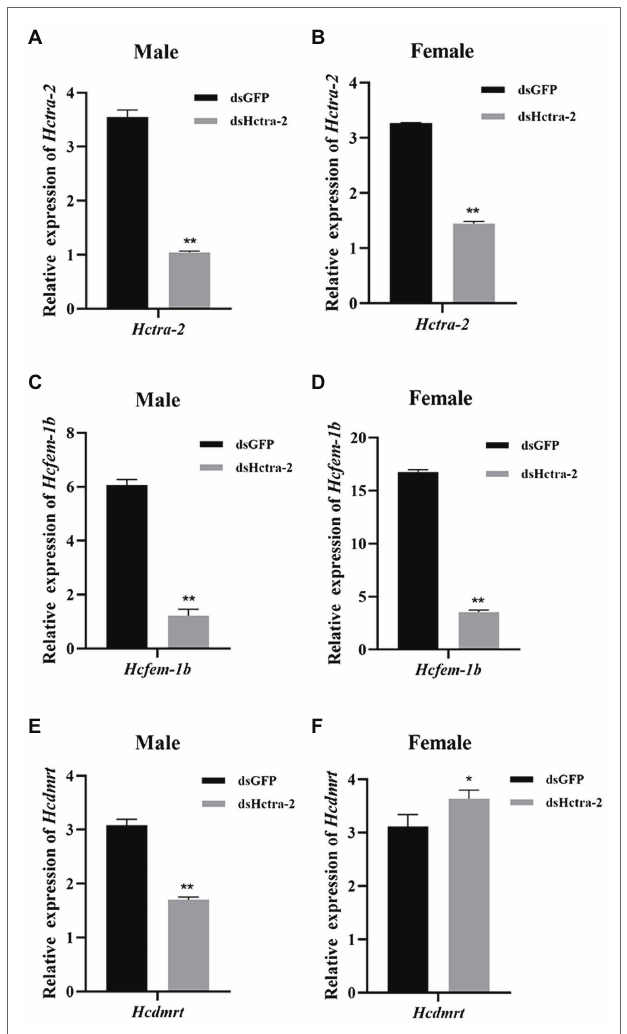
FIGURE 7 | Effects of dsHctra-2 injection on the expression of Hctra-2 , Hcfem-1b , and Hcdmrt genes in testes and ovaries of H. cumingii . dsGFP, treated with dsGFP and used as RNAi control group; dsHctra-2, treated with dsRNA of Hctra-2 as RNAi experiment group. (A) The expression of Hctra-2 gene in testes. (B) The expression of Hctra-2 gene in ovaries. (C) The expression of Hcfem-1b gene in testes. (D) The expression of Hcfem-1b gene in ovaries. (E) The expression of Hcdmrt gene in testes. (F) The expression of Hcdmrt gene in ovaries. Results are expressed as mean ± SD, and significance of comparison is defined as p < 0.05 (*) or p < 0.01 (**) by Student’s t